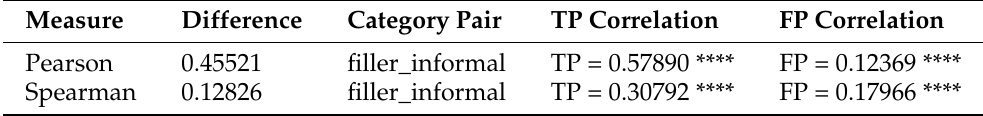
Table 37. Filler and Informal language in